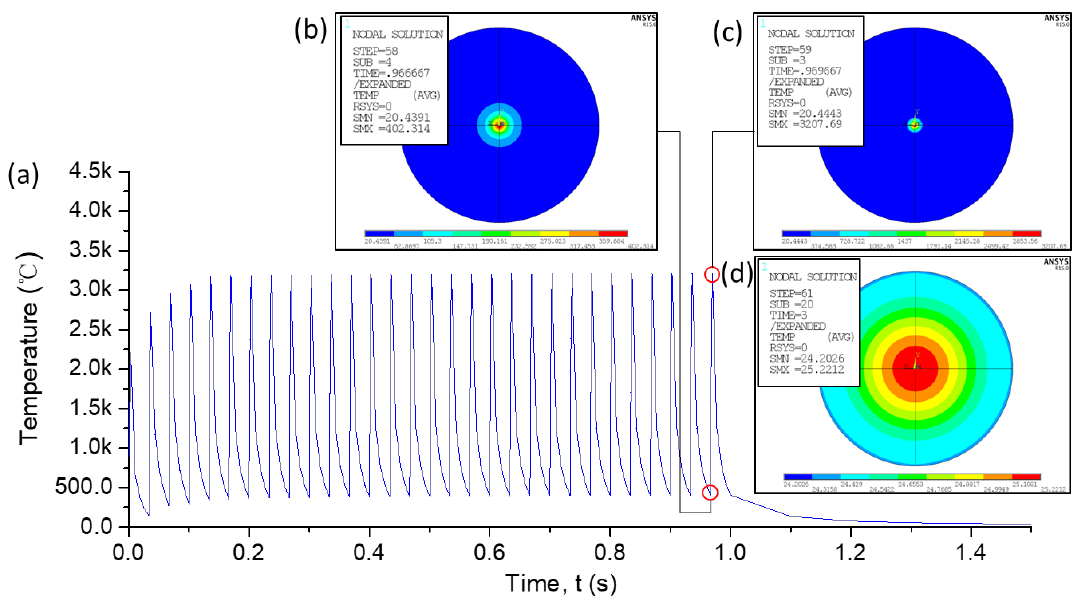
Figure 6. Simulated temperature curve and distributions during pulsed laser spot heating: ( a ) temperature curve, ( b ) t = 0.966667 s, ( c ) t = 0.969667 s, and ( d ) t = 3 s.